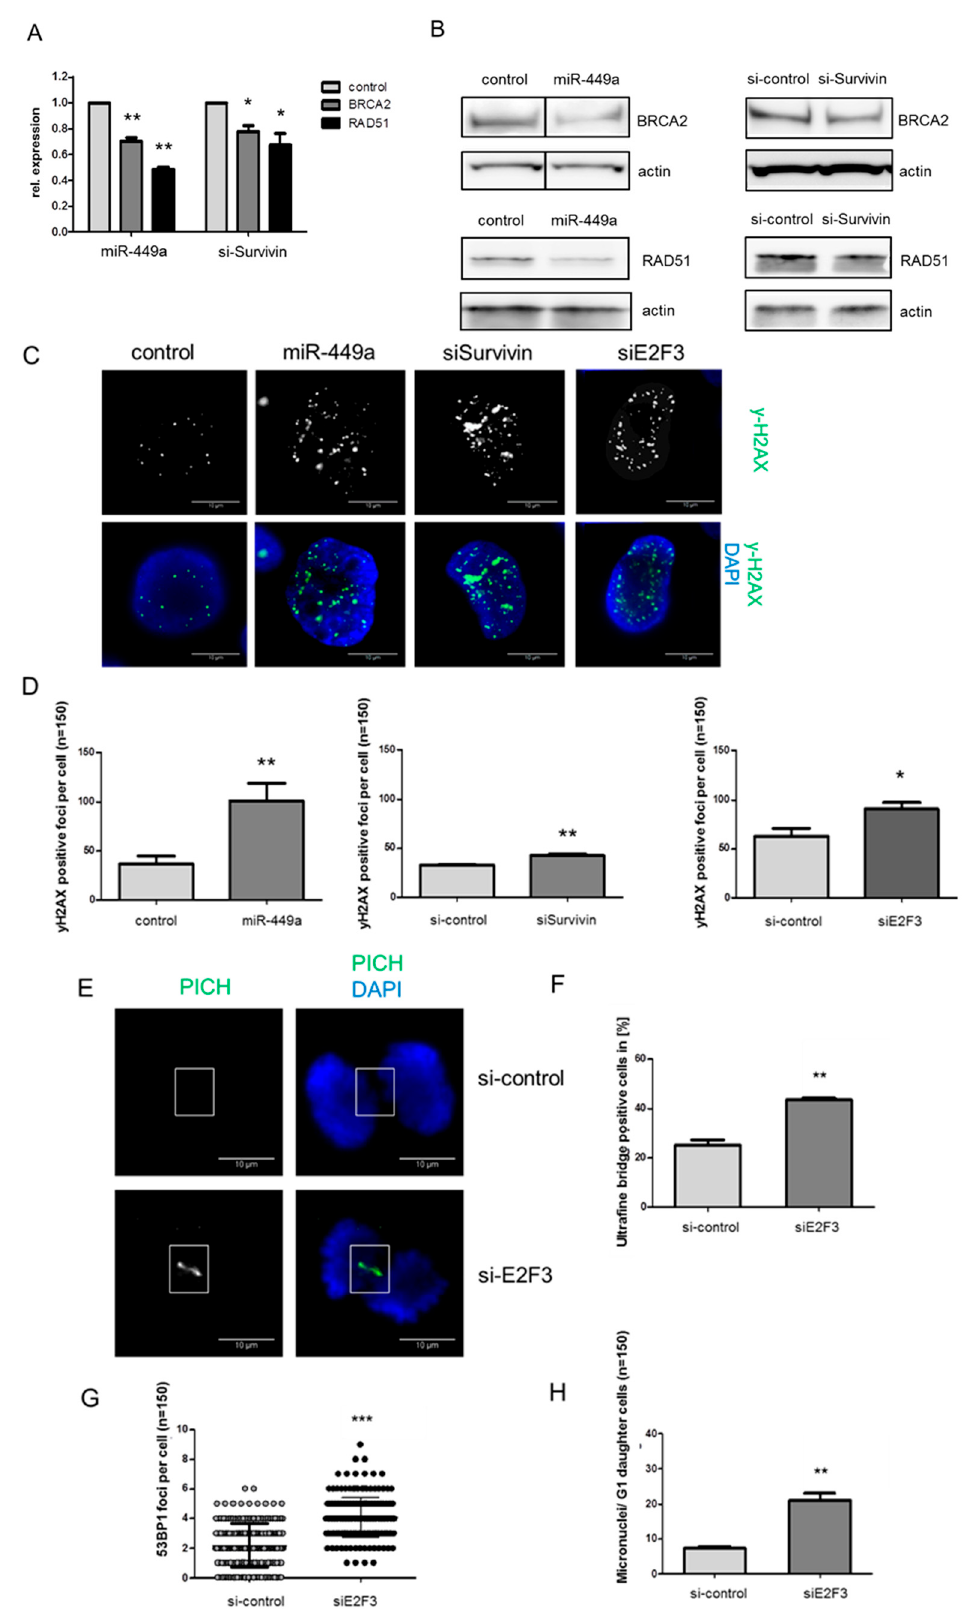
Figure 4. MiR-449a decreases expression of RAD51 and BRCA2 leading to increased yH2AX signals. ( A ) Expression of BRCA2 and RAD51 mRNA measured by RT-PCR 48 h after transfection with miR-449a-mimics/control or with siE2F3/si-control. ( B ) Expression of BRCA2 and RAD51 proteins using Western blotting in HCC38 cells. Actin was used as a loading control on the same blot but on a